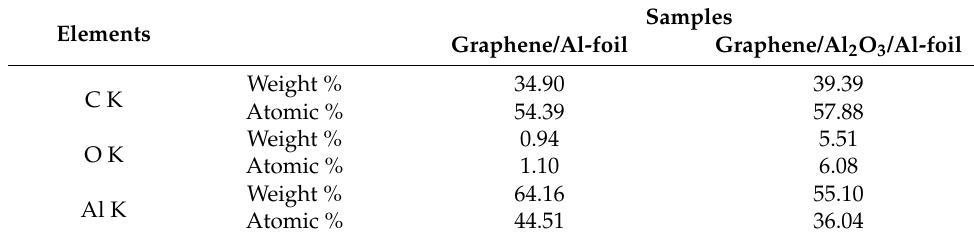
Figure 3. FESEM image of the graphene surface on ( a ) Al-foil/PET and ( b ) Al 2 O 3 /Al-foil/PET. ( c ) EDS elemental mapping of the graphene/Al 2 O 3 /Al-foil/PET presenting C K series, O K series and Al K series. Table 1. EDS elemental analysis of graphene over Al-foil/PET and Al 2 O 3